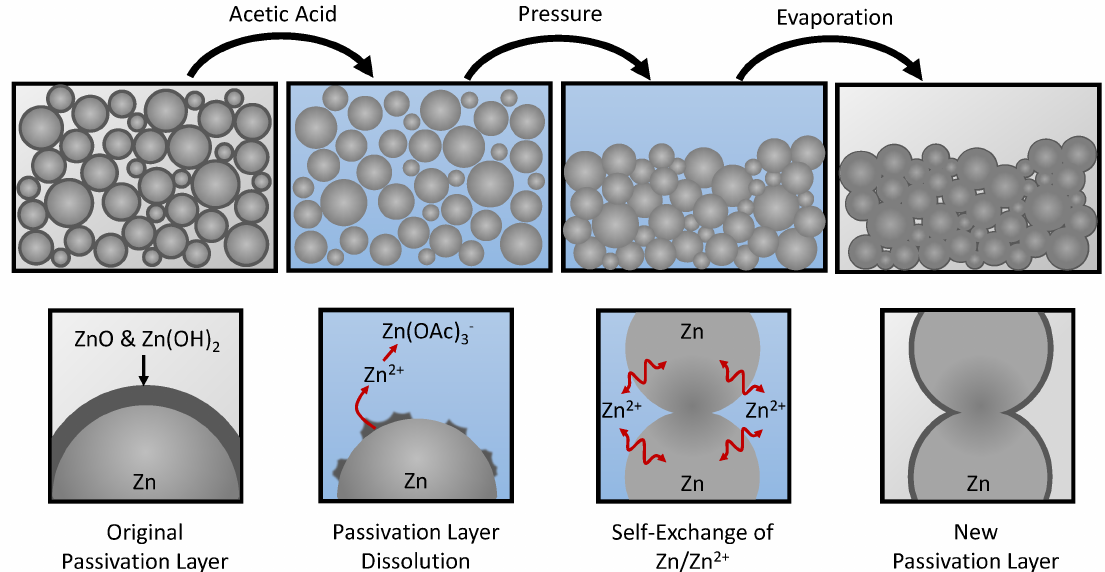
Figure 1. Schematic representation of the cold sintering process. Zn particles are initially covered by a passivation layer consisting primarily of ZnO and Zn(OH) 2 . Soaking the Zn particles in a solution of acetic acid dissolves the passivation layer and chelates the resulting Zn 2+ ions. Applying an external pressure facilitates the formation of contact interfaces between the Zn particles, which are sintered via the self-exhcange between Zn/Zn 2+ . The solution is evaporated and a new passivation layer forms over the surface of the sintered